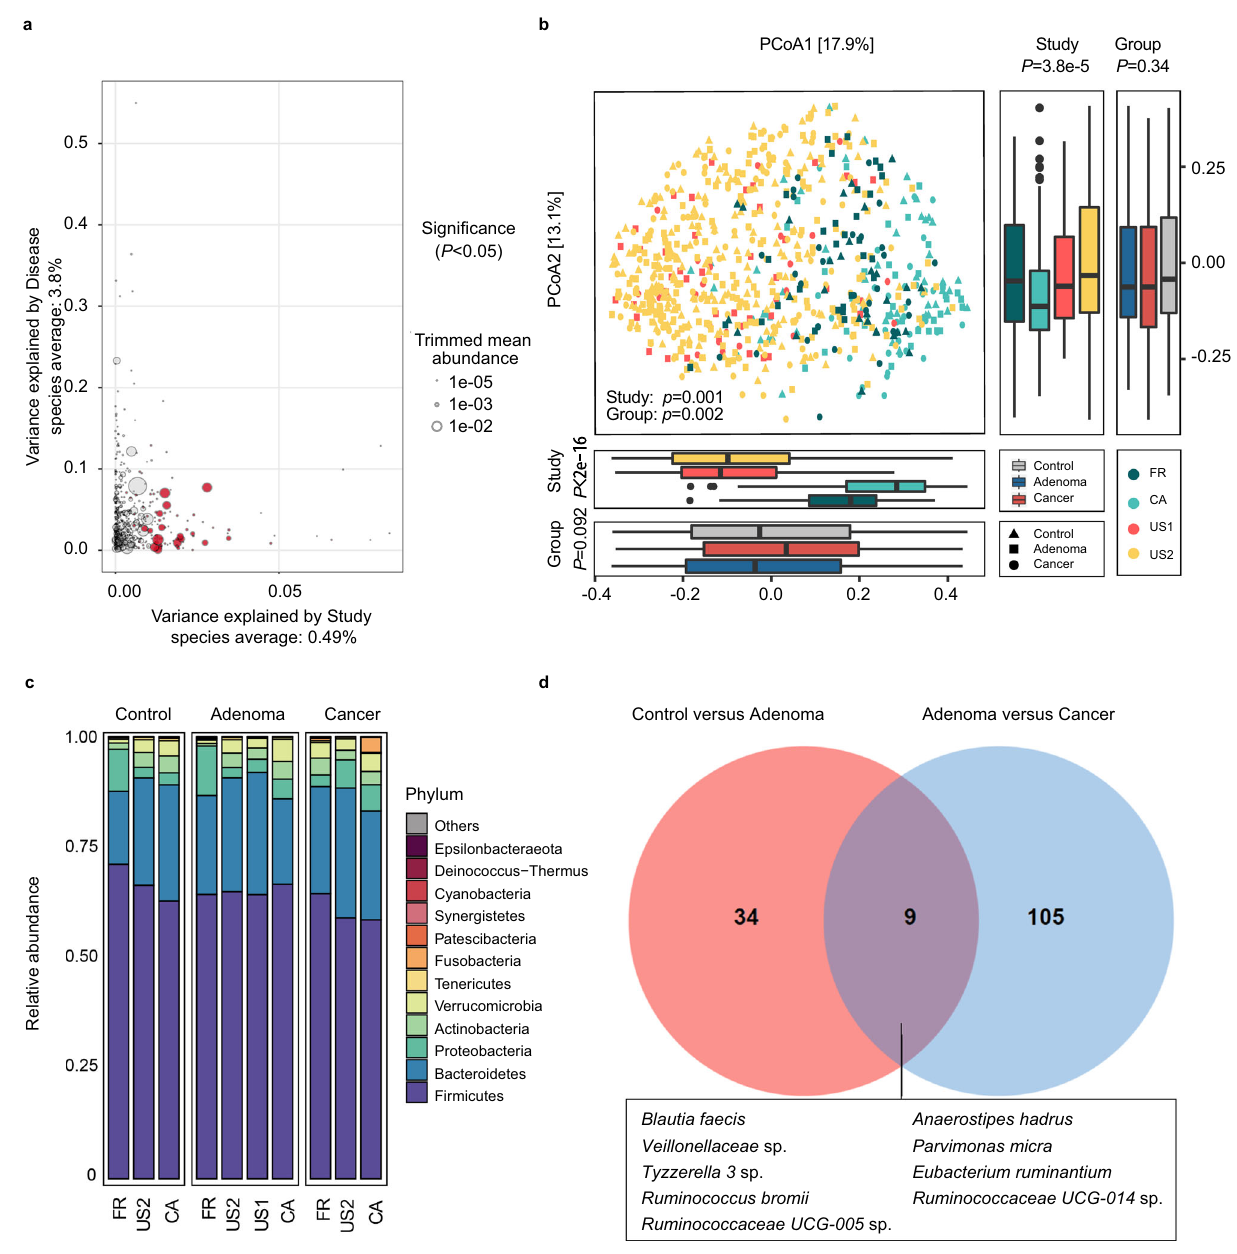
Fig. 1 Alterations of gut microbial composition in different disease status. a Variance explained by disease status (adenoma versus cancer) is plotted against variance explained by study effects for individual ASVs. The signi fi cantly differential ASVs are colored in red and the dot size is proportional to the abundance of each ASV. P values were from a two-sided blocked Wilcoxon rank-sum test. Source data and exact P values are provided as a Source Data fi le. b Principal coordinate analysis of samples (control, n = 252; adenoma, n = 306; cancer, n = 217) from all four studies based on Bray – Curtis distance, which shows the fecal microbiota composition was different among studies ( P = 0.001) and groups ( P = 0.002). P values of beta diversity based on Bray – Curtis distance were calculated with PERMANOVA. The study is color-coded and the group (control, adenoma, and cancer) is indicated by different shapes. The upper-right and the bottom-left boxplots illustrate that samples projected onto the fi rst two principal coordinates broken down by study and disease status, respectively. P values of the fi rst and second principal components were calculated with a two-sided Kruskal – Wallis test for study and group. All boxplots represent the 25th – 75th percentile of the distribution; the median is shown in a thick line at the middle of the box; the whiskers extend up to values within 1.5 times of IQR, and outliers are represented as dots. Source data are provided as a Source Data fi le. c Relative proportions of bacterial phyla in healthy controls, adenomas, and CRC across four different studies. d Venn diagram shows the overlap of differential ASVs assigned at species level between adenomas and healthy controls or there was no common ASV in the two sets of biomarkers between control-vs-adenoma and control-vs-CRC (Supplementary Fig. 5). These results highlighted that microbial markers aimed to detect CRC are speci fi c and exclusive, not as applicable for diagnosing adenoma.